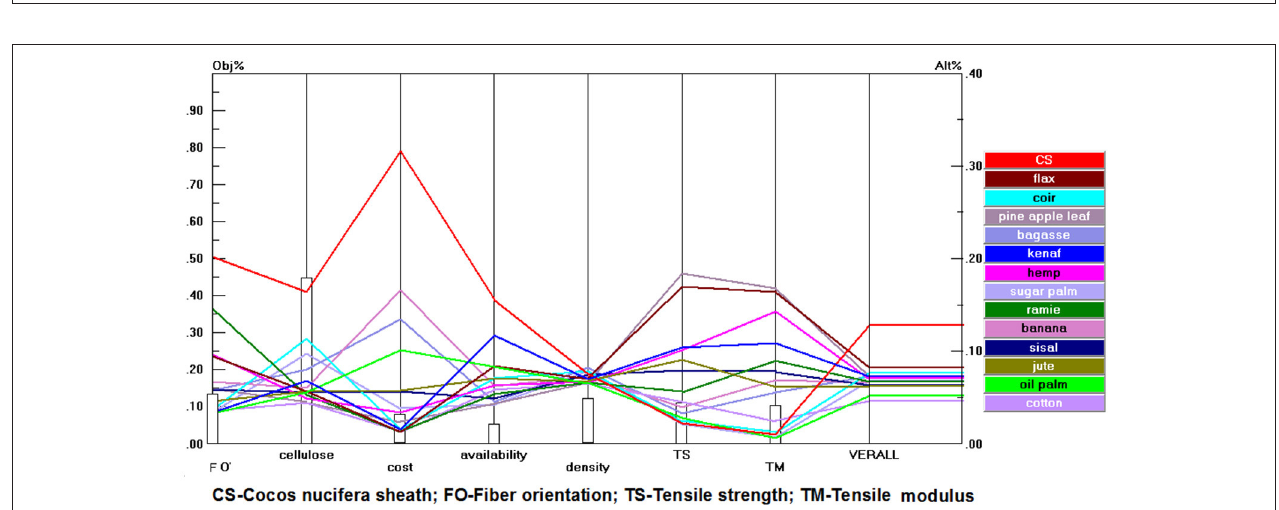
FIGURE 8 | Sensitivity graph of criteria with respect to goal when the priority vector of cellulose is increased by 20% (24.5–44.5%).